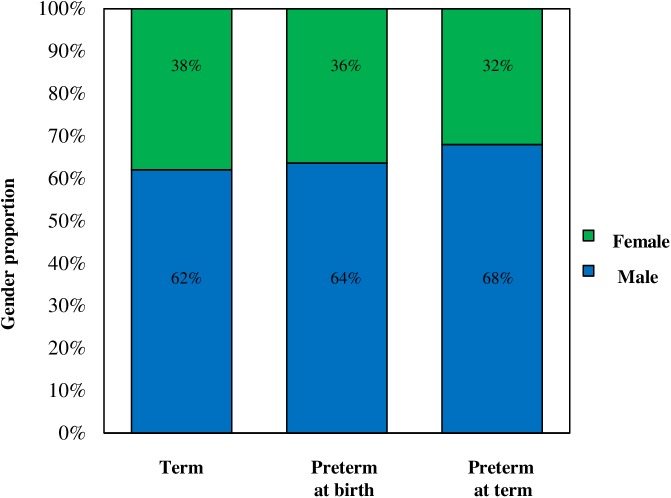
Proportion of males and females in term, preterm at birth and preterm at term infant cohorts.